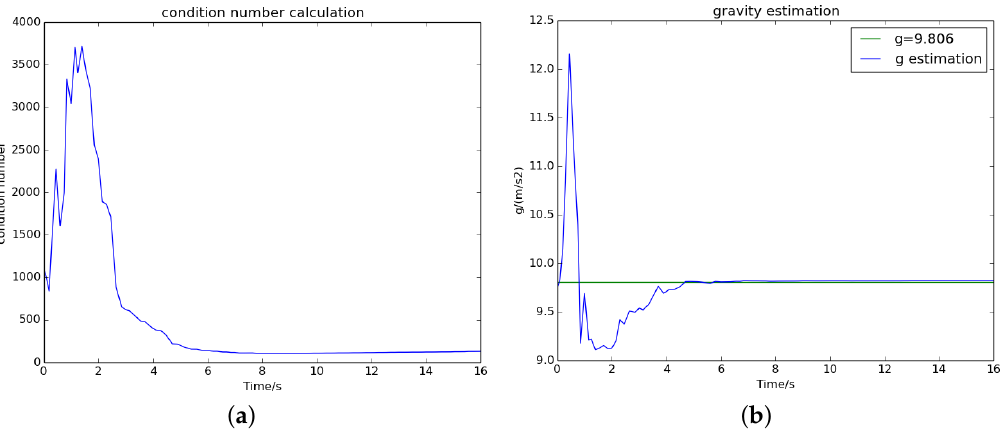
Figure 7. The convergence process of ( a ) the condition number and ( b ) the estimated gravity on sequence